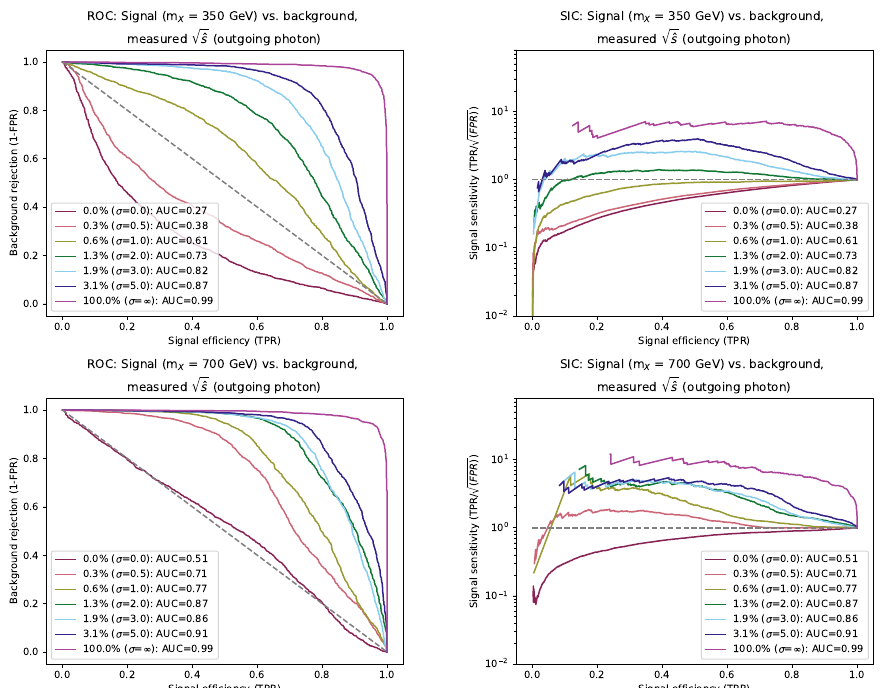
√ ˆ s , in the form of = 350 GeV (top) and m = 700 GeV (bottom) vs. X X